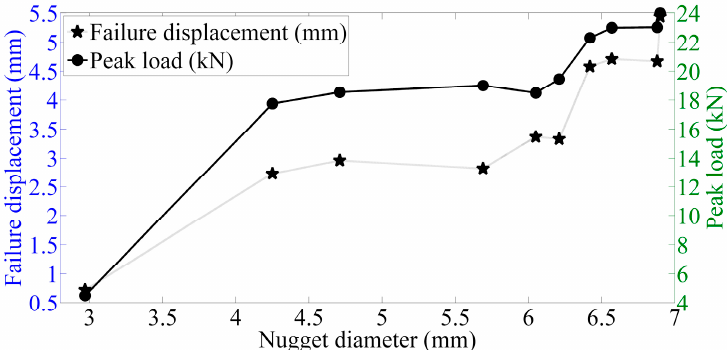
Figure 17. The relationships between the nugget diameter, peak load, and failure displacement.